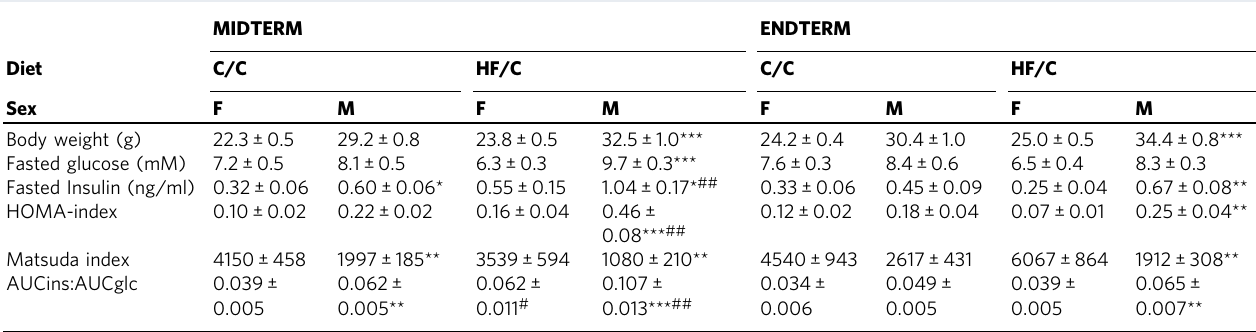
Table 1 Body weight, fasted glucose, and insulin levels and markers of insulin sensitivity and β -cell function in female (F) and male (M)